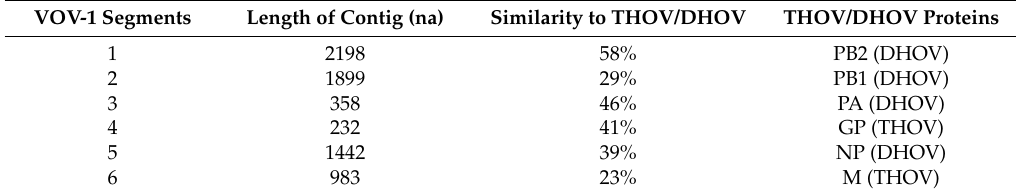
Table 4. Comparison of the Varroa orthomyxovirus-1 (VOV-1) contigs to the Orthomyxoviruses Thogoto and Dhori (THOV and DHOV).